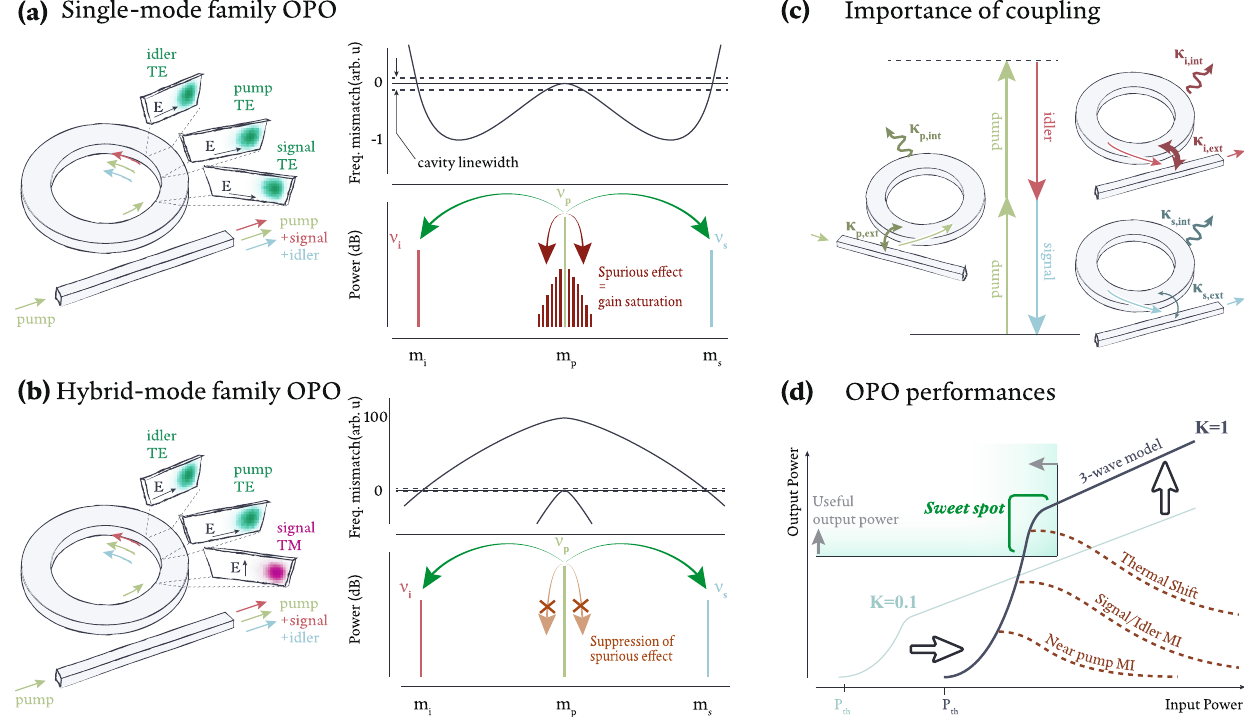
Fig. 1 | Ingredients for a high-performance χ (3) microchip OPO. a , b (Left) SchematicillustrationofOPOintwocon fi gurations,basedonasinglemodefamily ( a ) and a hybrid mode family ( b ) scheme. In each, an input pump (frequency ν p ) is coupled into the microring to generate output signal ( ν s ) and idler ( ν i ) if the par- ticipating modes are phase- and frequency-matched. In a , all modes are chosen from the same transverse-electric (TE) mode family (TE 0 in this case). In b , the modes are chosen from different transverse mode families, including transverse- magnetic (TM) mode families ({TE 0 ,TE 0 ,TM 0 } for { ν i , ν p , ν s } in this case). (Right) Frequency mismatch Δ ν (top) and expected OPO spectrum (bottom) for the two approaches. In a , frequency matching ( Δ ν =0) is achieved through a dispersion balance that results in weakly normal dispersion near the pump, which allows for spurious competitive processes that saturate the nonlinear gain. In b , the use of mode families with different effective indices enables frequency matching while supporting strong normal dispersion around the pump to largely suppresses